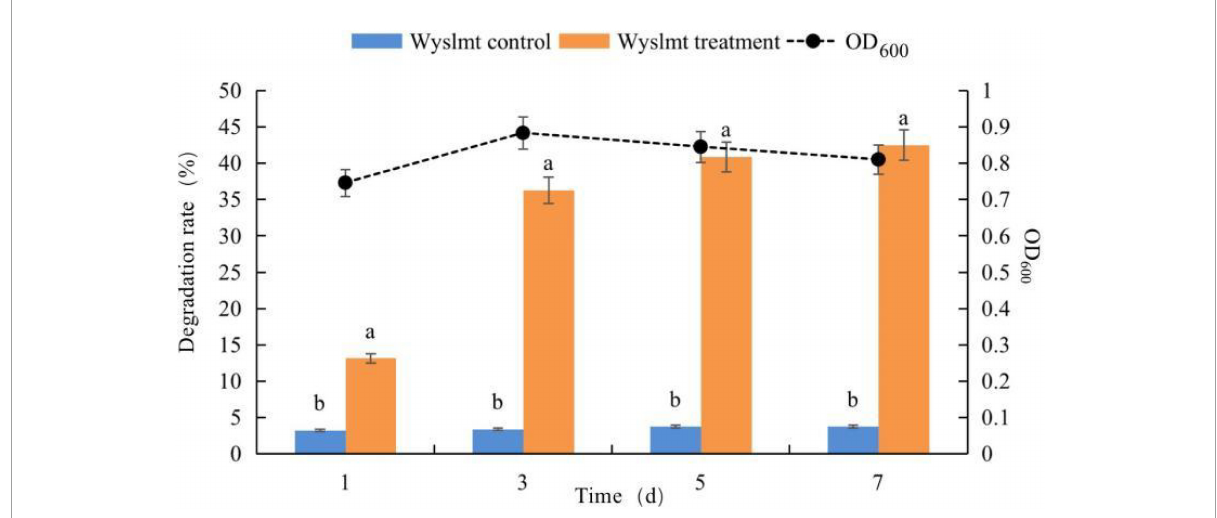
FIGURE2 Growth of the Wyslmt strain and associated Diquat degradation. Error bars represent the standard deviation for three replicate samples. Different letters indicate significant differences between treatments ( P < 0.05).